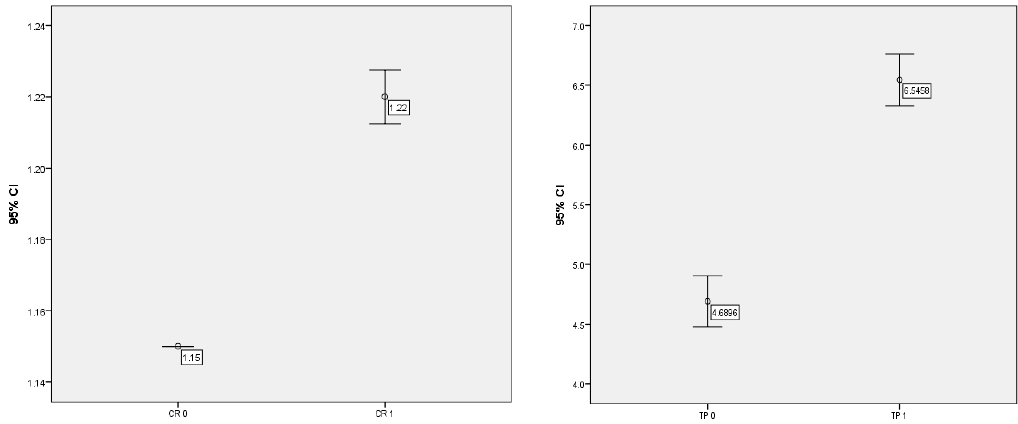
Table 6. Paired sample statistics (1450 ◦